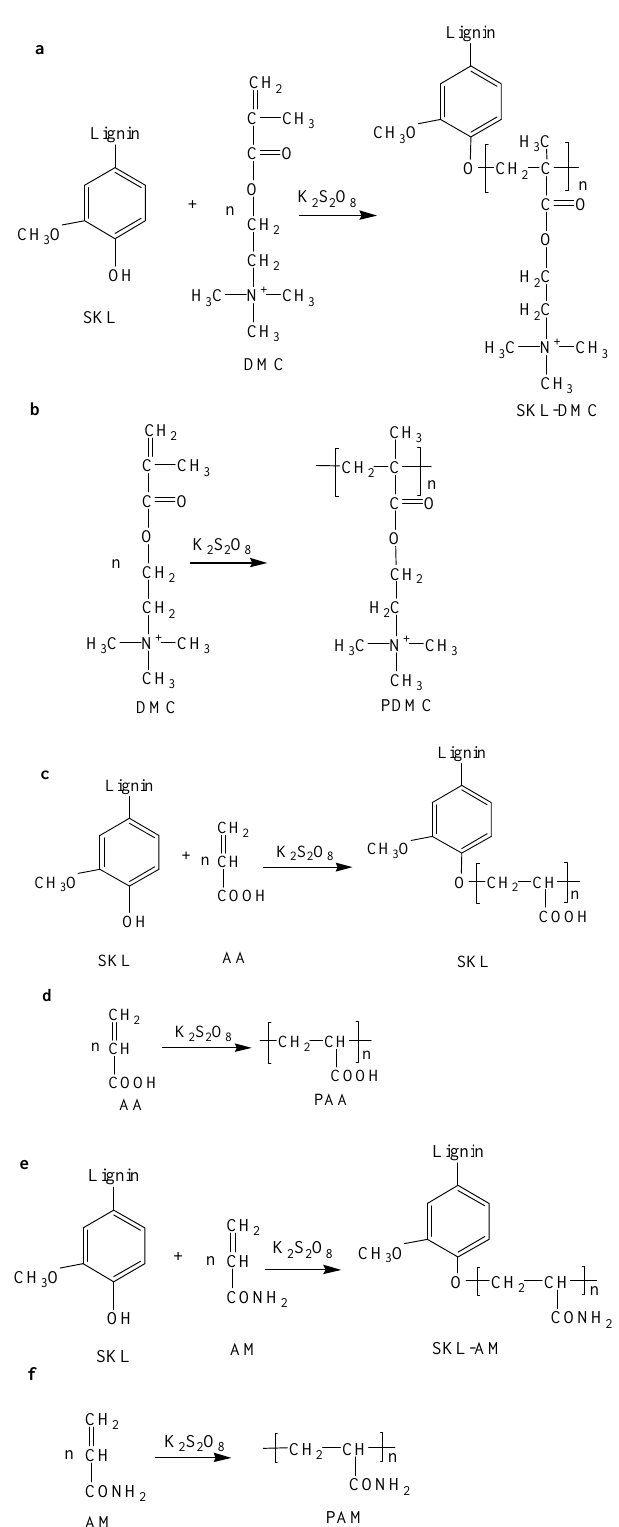
Fig ure 1. Mechanism of the copolymerization of softwood kraft lignin (SKL) with monomers (( a ) SKL ‐ DMC, ( b ) PDMC, ( c ) SKL ‐ AA, ( d ) PAA, ( e ) SKL ‐ AM, ( f ) PAM).